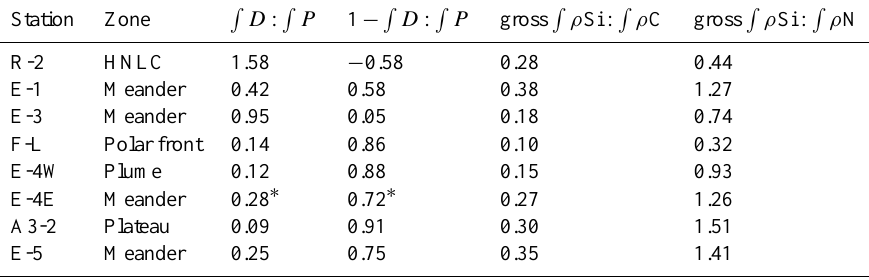
Table 3. Dissolution-to-production ratio ( R D : R P ), fraction of the silica production supported by new silicic acid (1 − R D : R P ) and silicon-to-carbon (C) and silicon-to-nitrogen (N) uptake ratios (C and N assimilation were measured by Cavagna et al., 2014). ρ N represents both nitrate and ammonium uptake. All these values are integrated over the euphotic layer (1% of surface photosynthetically active radiation).